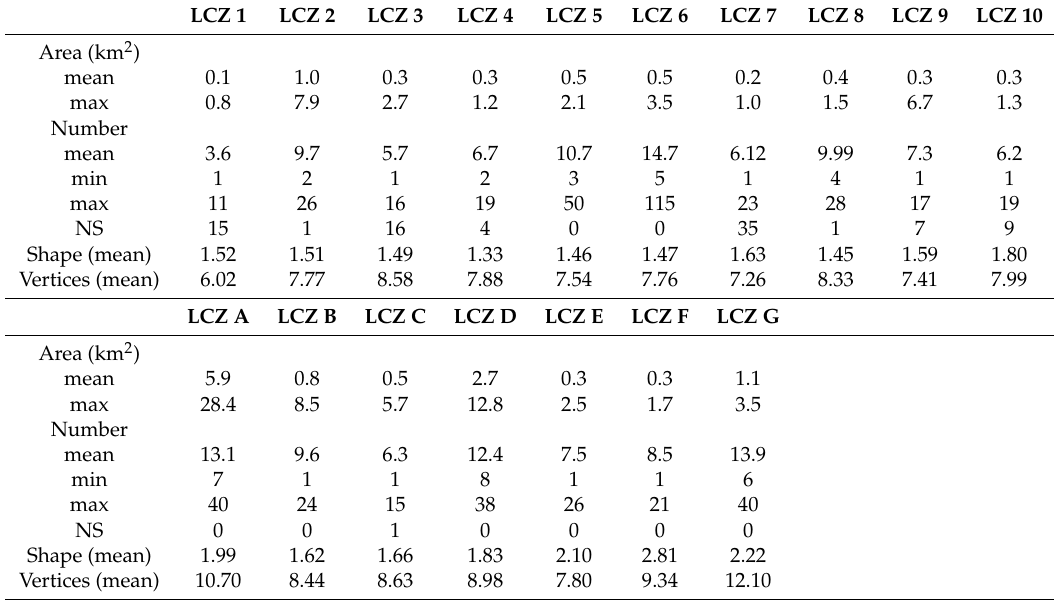
Table 4. TA characteristics for area, number, shape and node count of TAs, NS = not selected by a